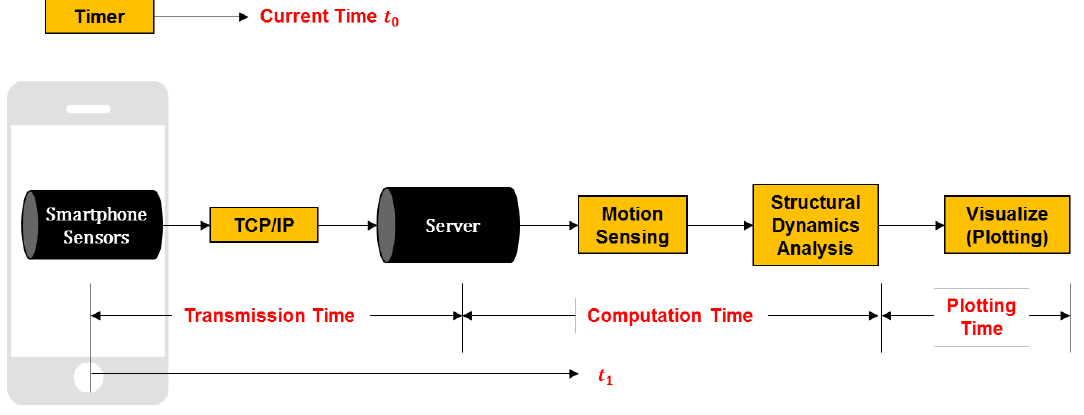
Figure 13. An example of turn detection from a gyroscope and a magnetic field sensory data.